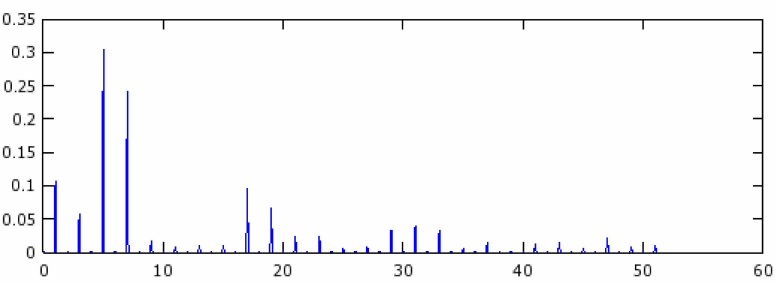
Figure 17. The amplitudes of MMF harmonics in the air-gap. The 12-slot structure is fed by two three-phase supplies. The currents are synchronous.